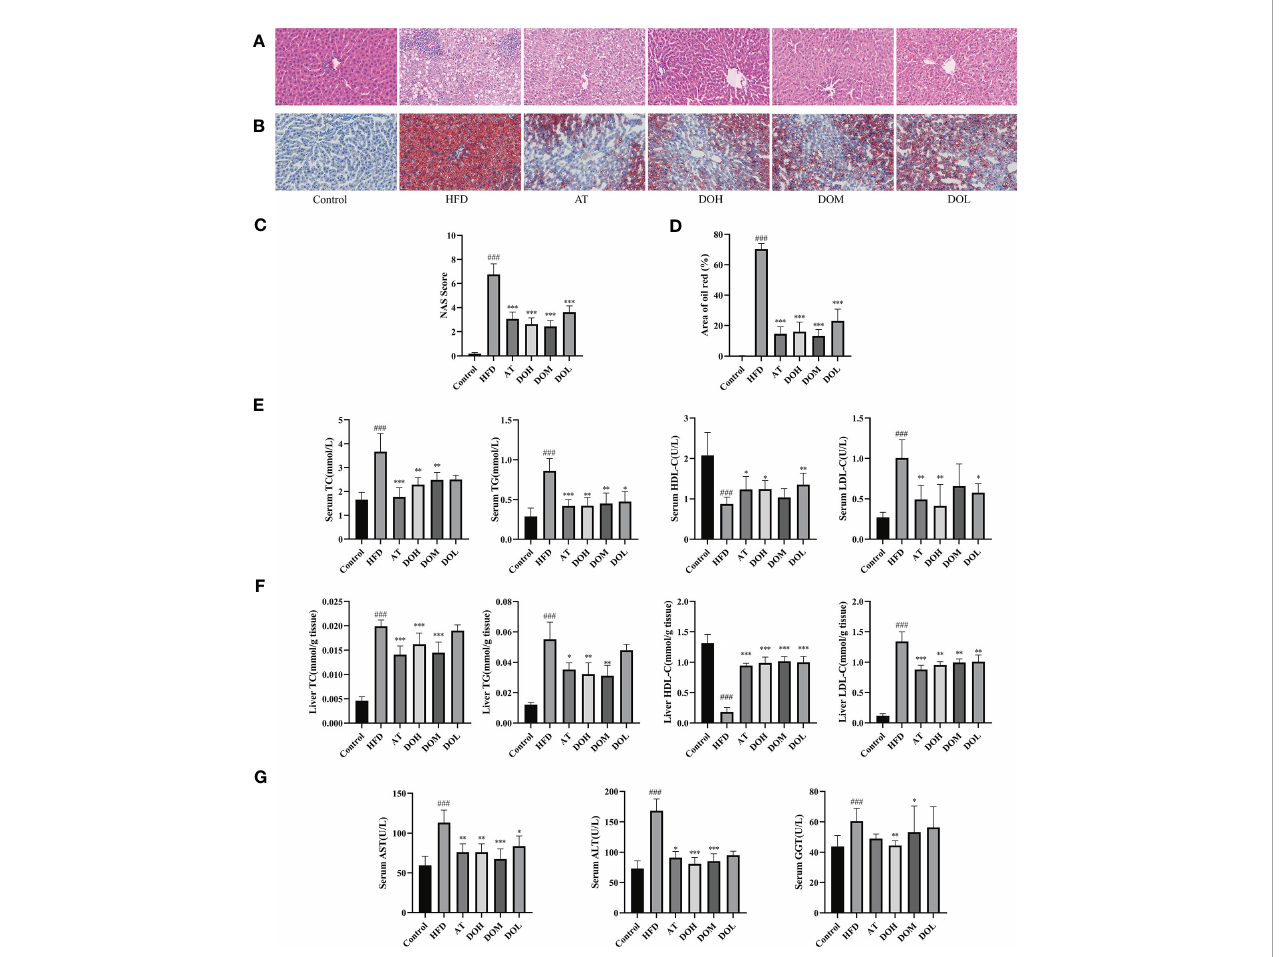
FIGURE 2 Detection of liver pathology and biochemical criteria. (A) Representative H&E stained liver samples by group (400x magni fi cation); (B) representative images of oil red O stained liver samples by group (400x magni fi cation); (C) liver NAS scores by group; (D) oil red O staining area by group; (E) serum lipid content by group; (F) liver lipid content by group; (G) serum AST, ALT and GGT levels by group. All data are shown as the mean ± SD (n =8). ### p < 0.001 vs. the Control group; * p < 0.05, ** p < 0.01, *** p < 0.001 vs. the HFD